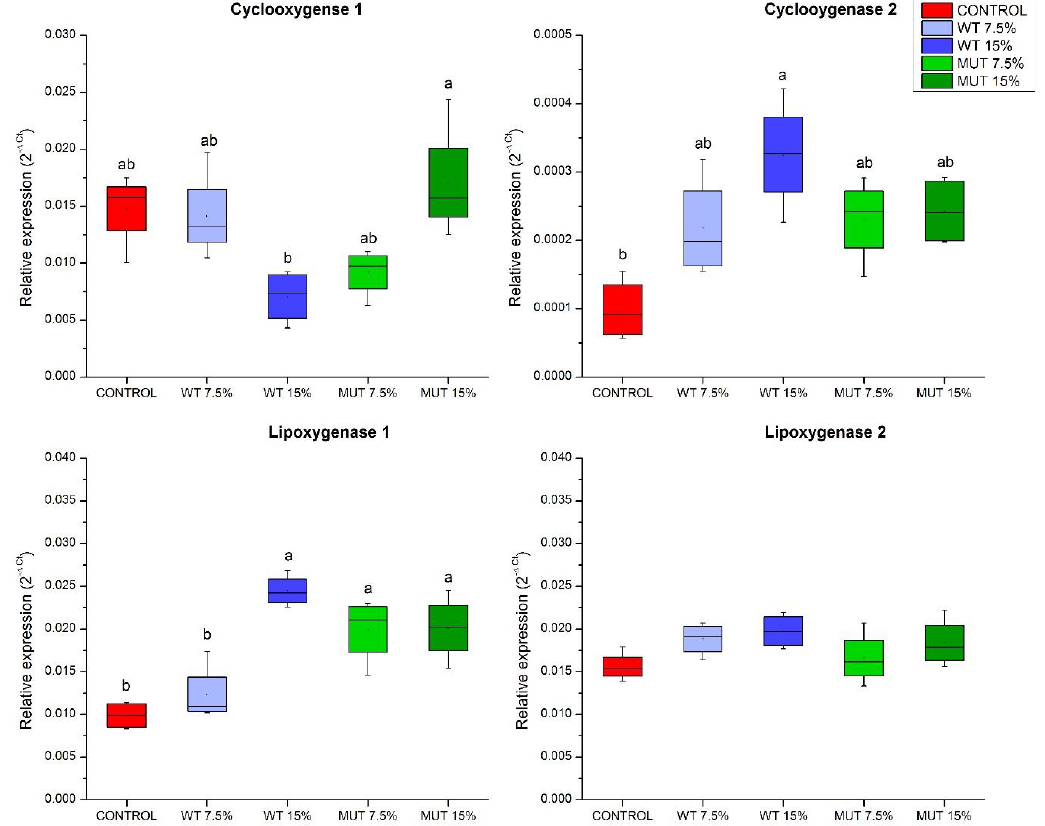
Figure 1. Expression of eicosanoid synthesis genes in the gut of zebrafish fed diets supplemented with Lobosphaera incisa wild type (WT) and mutant strain (MUT). Values in box plots show relative gene expression levels normalized to elongation factor 1α ( EF1α ) and expressed as 2 −Δ C t ( n = 4 biological replicates, each replicate is a pool of five fish). Different lowercase letters denote significant differences ( p < 0.05) between treatments.